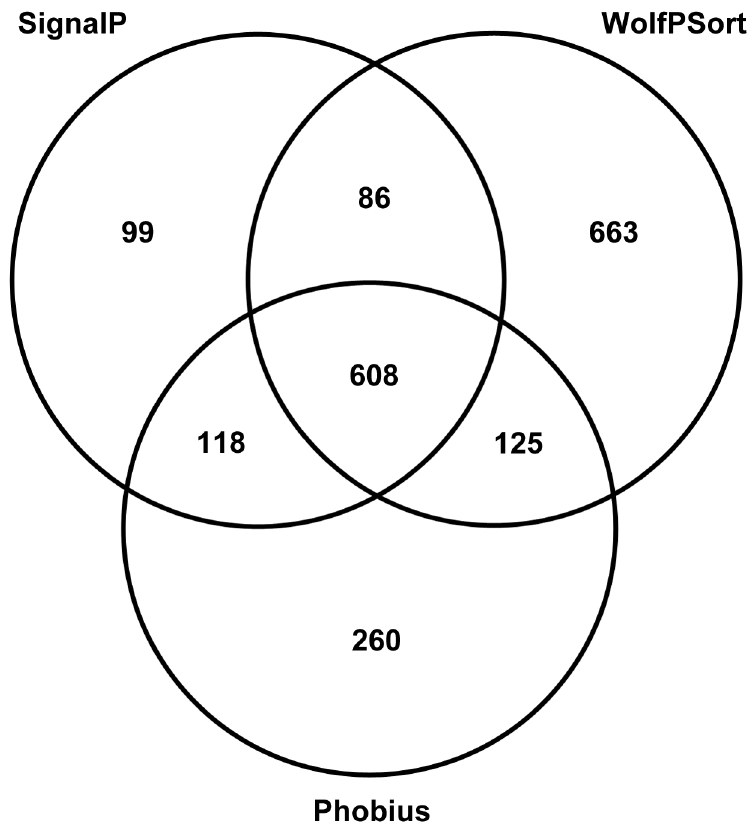
Figure 4. Summary of secreted proteins predicted by 3 different methods: SignalP, WolfPsort and Phobius.